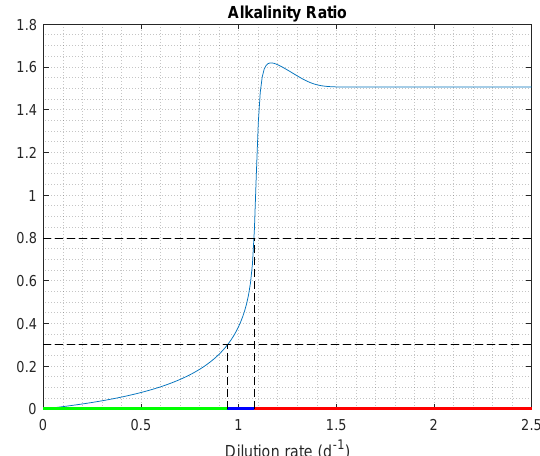
Figure 1: The steady state Alkalinity ratio (AR) as a function of dilution rate between 0 and 2.5 d − 1 . In dilution rate axes, the green band shows a range of dilution rate for which the AD process is stable. The red band repre- sents instability.